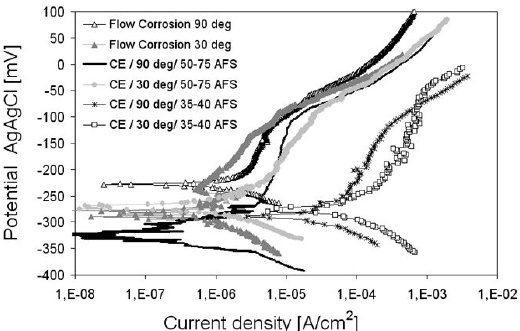
Figure 10. Potentiodynamic curves obtained for AISI 304L steel during liquid impingement and erosion-corrosion tests with 90º and 30º in a 3.5% NaCl solution and slurries with two different particle